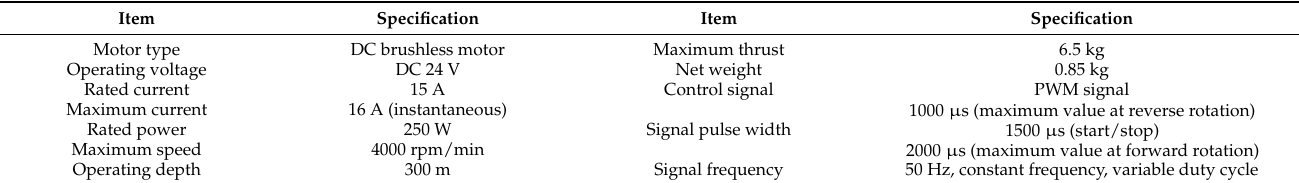
Table 1. Specifications of the underwater thruster.